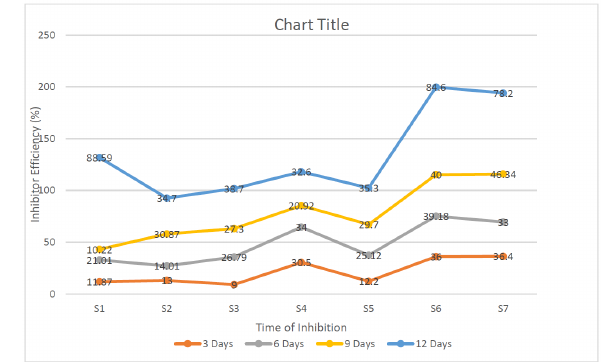
Figure 6: Plot of S6 (Inhibition eflciency versus Time of inhibition (days).